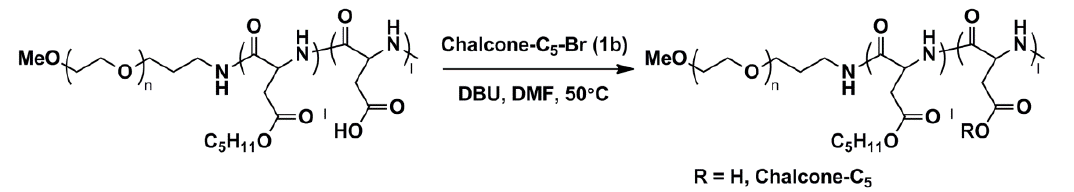
Table 1. Chal-C 5 conjugation to PEG-P(Asp(26)-pentyl(76)).